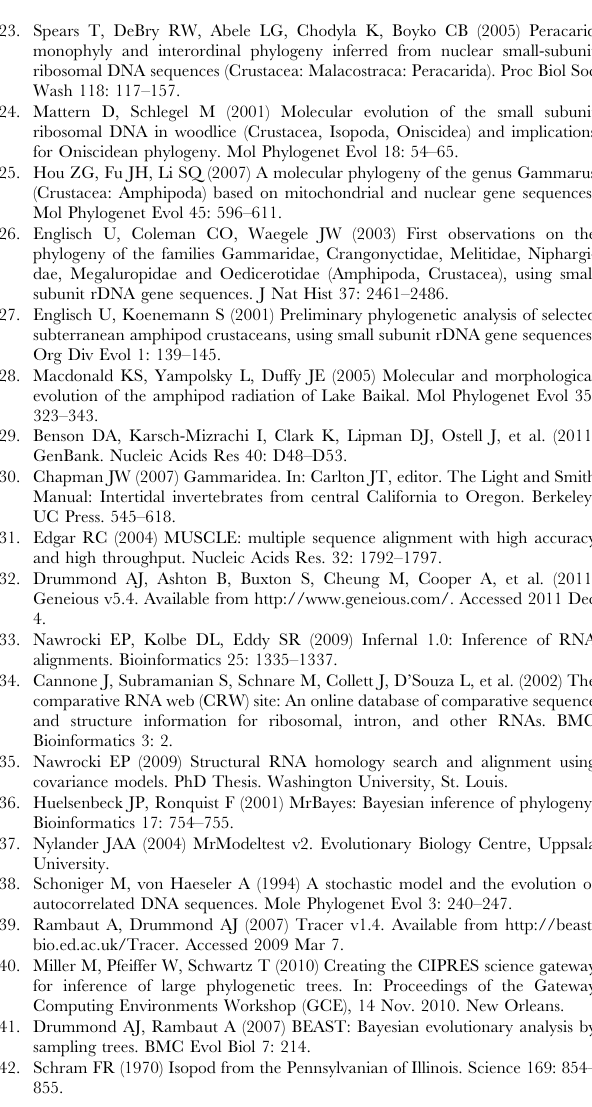
Figure S1 Trait data. Panels A to K show mean trait values for each species ( 6 1 Standard Error). Non-significant outcomes of laboratory experiments (e.g., temperature trials in panel C, feeding trials in panels D-G) are shown as 0. Panel C shows the reduction in survival time (in hours) in elevated water temperature (25 u C) relative to controls. Table S1 Additional 18S sequences. Table S2 Results of tests for phylogenetic signal with a subset of species. We report Blomberg’s K for continuous traits and Pagel’s l for discrete traits, plus the p-value for the corresponding significance test (H0: signal no greater than 0). All values are averaged over 200 trees sampled from the posterior